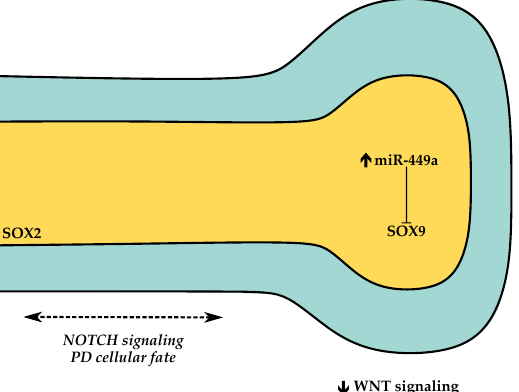
Figure 3. Simplified representation of the signaling pathways implicated in the canalicular stage. Proximal SOX2+ cells generate conducting airway cells (neuroendocrine, secretory, multiciliated and basal). Distal SOX9+ cells generate alveolar epithelial